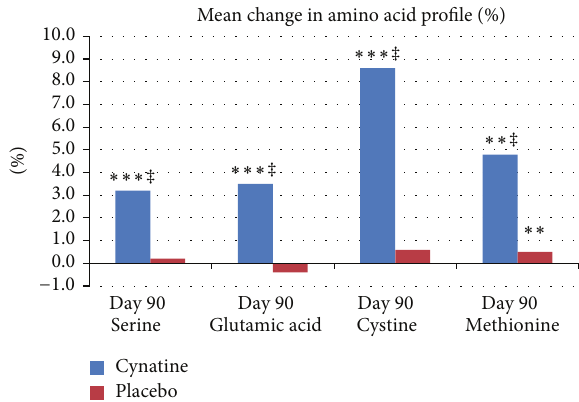
Figure 2: Mean percent change in amino acid profile from baseline for placebo and Cynatine HNS. ∗∗ 𝑃 < 0.01 and ∗∗∗ 𝑃 < 0.001 within group to baseline; ‡ 𝑃 < 0.001 between groups to baseline.